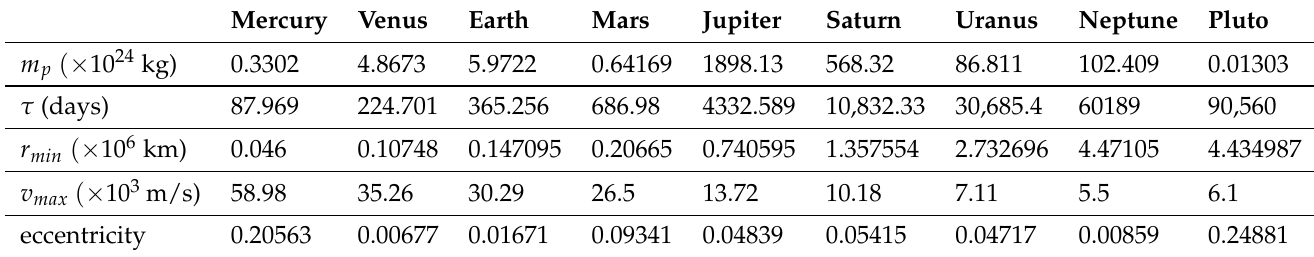
Table 1. Initial conditions used in the calculations, where m p denotes the planet mass, τ the orbit period, r min the perihelion, and v max the perihelion